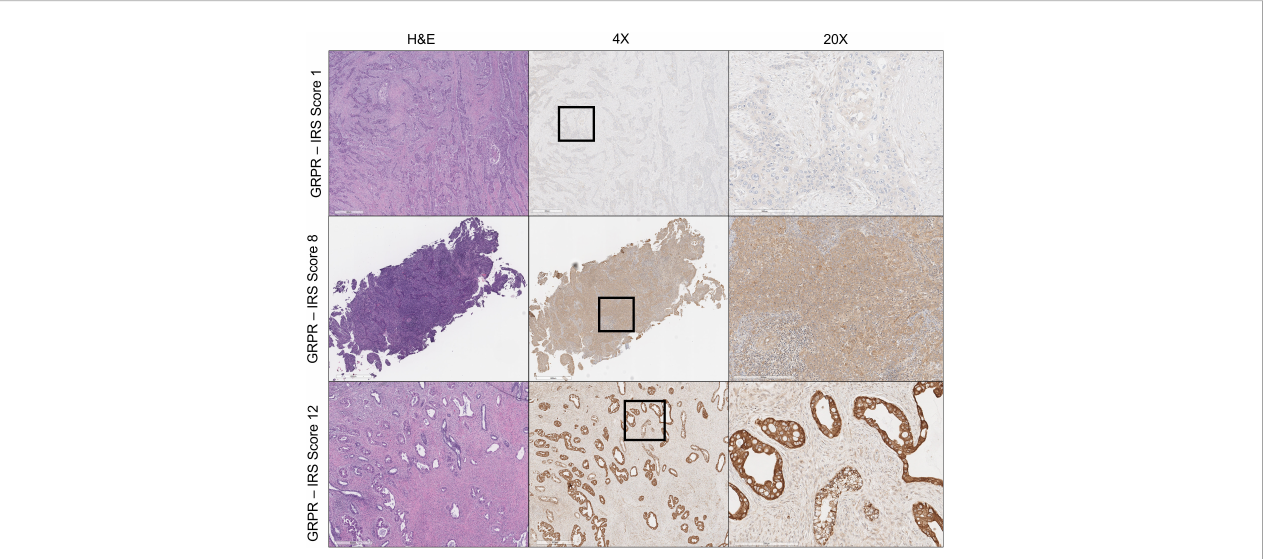
FIGURE 1 Gastrin- releasing peptide receptor (GRPR) immunoreactivity in uterine cervix cancer. Hematoxylin and eosin (H&E) staining of uterine cervix cancer at ×4 magni fi cation appears in the left column. GRPR staining of uterine cervix cancer at ×4 magni fi cation is in the center, with regions of further magni fi cation boxed. GRPR staining of uterine cervix cancer at ×20 magni fi cation appears in the right column. IRS score is indicated for each row (e.g., percentage of positive cells [4] × intensity of staining [3] = 12: strongly